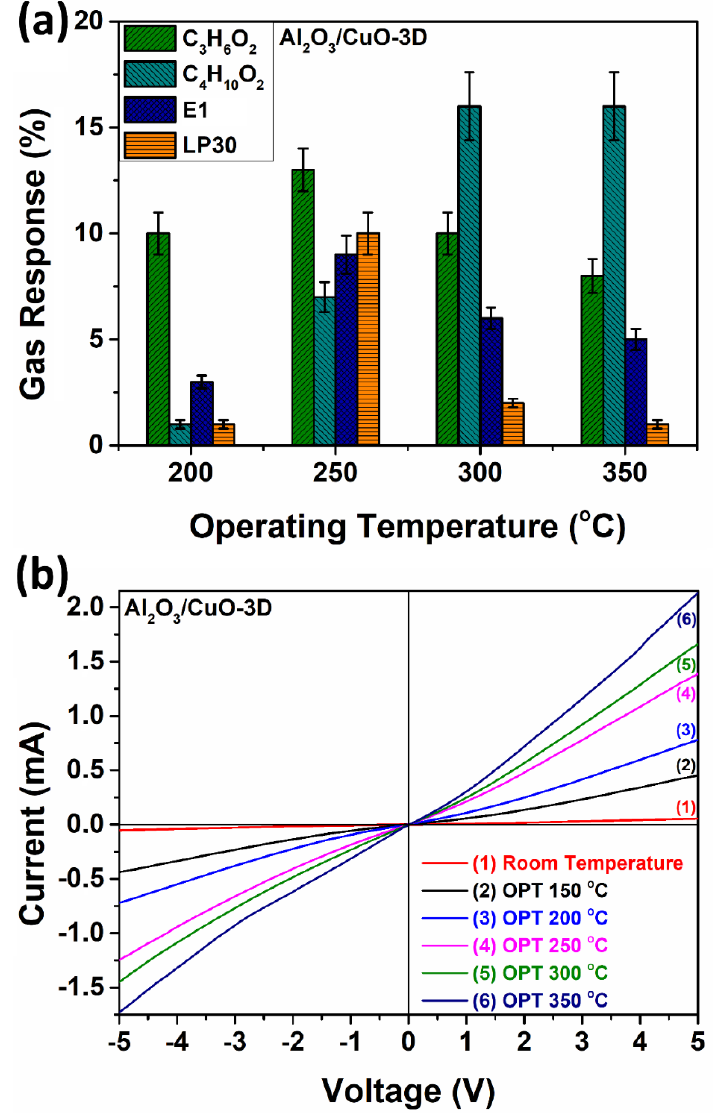
Figure 9. ( a ) Gas response to several types of vapor (100 ppm) formed in battery electrolytes in dependence of operating temperature for the Al 2 O 3 /CuO-3D devices; ( b ) I/V-curves for various op- erating temperatures for same Al 2 O 3 /CuO-3D